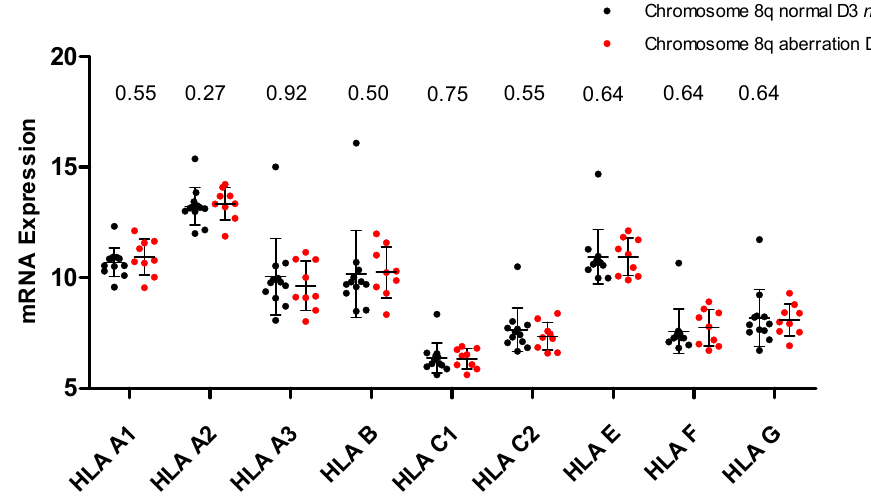
Figure 3. mRNA expression of all D3 tumors split on chromosome 8q status, shown for multiple probes ( p -values shown were obtained using the Mann-Whitney U-test, comparing D3 / chr8q normal ( n = 12) with D3 / Chr8q aberrant tumors ( n =